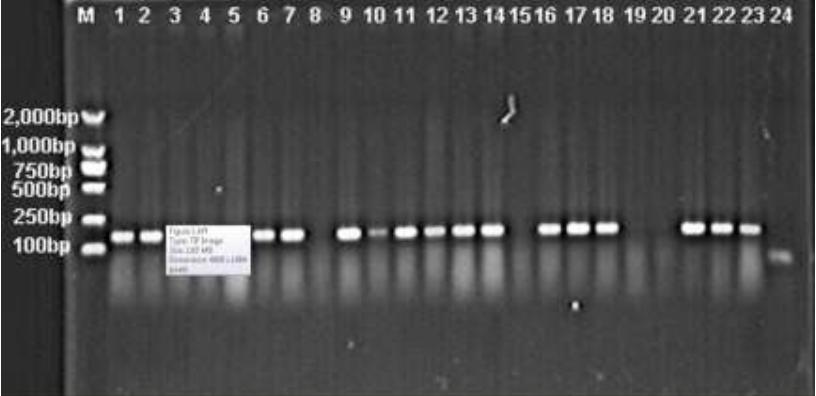
Figure 1. Electrophoresis of the PCR amplification products of intI1 gene. M, DL 2000 DNA Marker; 1–23, A. baumannii isolates; 24, Negative control isolate. Positive bands show the PCR products of intI1